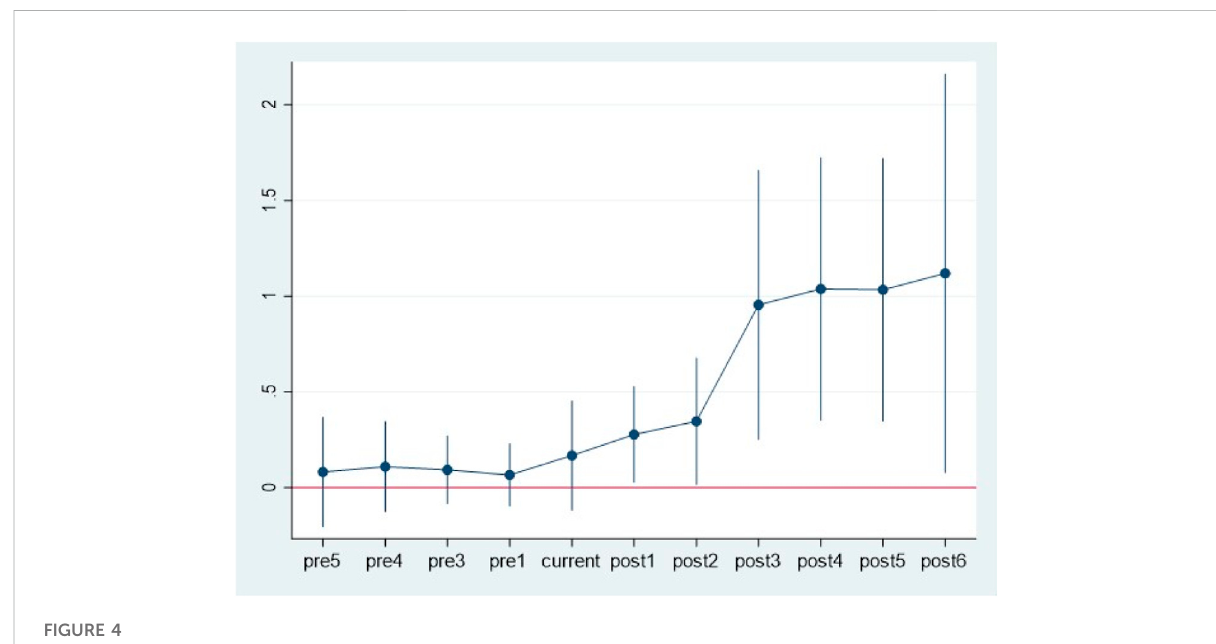
FIGURE 4 Result of parallel trend